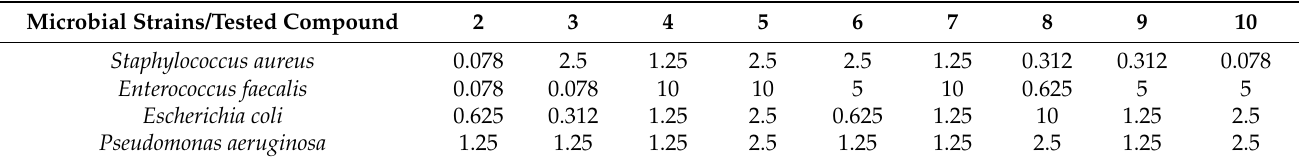
Table 3. The MBEC values (mg/mL) of the tested compounds.